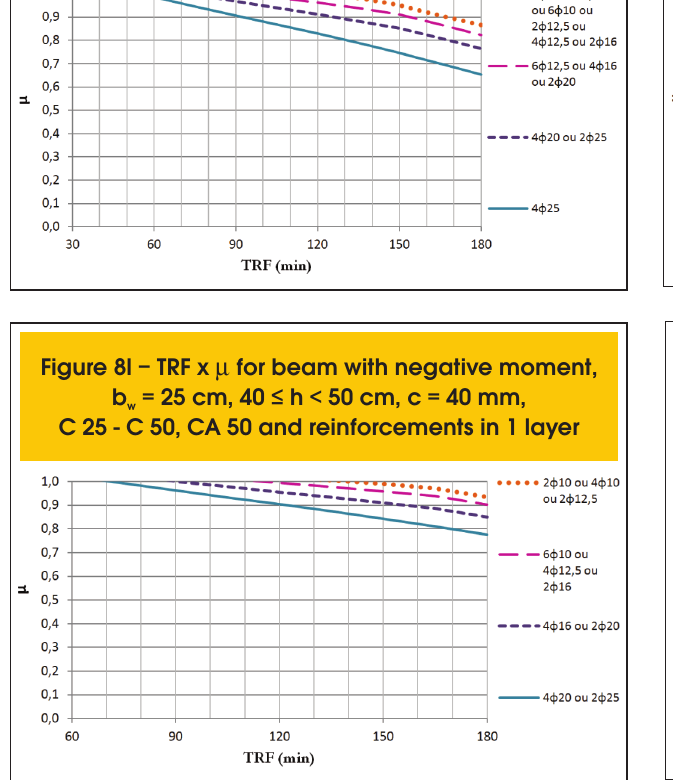
Figure 8p – TRF x m for beam with negative moment, b = 25 cm, h ≥ 60 cm, c = 25 mm, w C 25 - C 50, CA 50 and reinforcements in 1